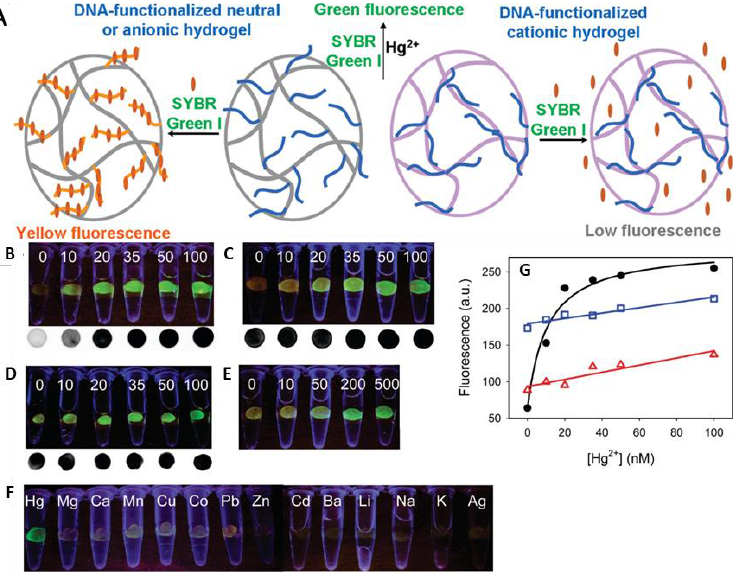
Figure 14. ( A ) Schematic representation of the DNA-functionalized neutral, anionic, and cationic hydrogels upon addition of fluorescence marker SYBR green. The neutral or anionic gel shows yellow fluorescence, and the cationic gel shows low fluorescence in the absence of Hg 2+ . When Hg 2+ is present, green fluorescence can be observed. ( B – F ) Hydrogel mercury sensor sensitivity obtained using a digital camera (the top panels) and a gel documentation system (the lower panels) for cationic (20% allylamine) ( B ), neutral ( C ), and anionic gels ( D ). ( E ) Detection of Hg 2+ in Lake Ontario water using the 20% allylamine gels. The numbers on the top of each sample are Hg 2+ concentrations in nM. ( F ) Responses of the sensors quantified using the gel documentation system. Cationic gel: black dots, neutral gel, an red triangles; negative gels: blue squares. ( G ) Sensor selectivity test with 1 µ M metal ion each (Reprinted and adapted with permission from [167]. Copyright 2011 American Chemical